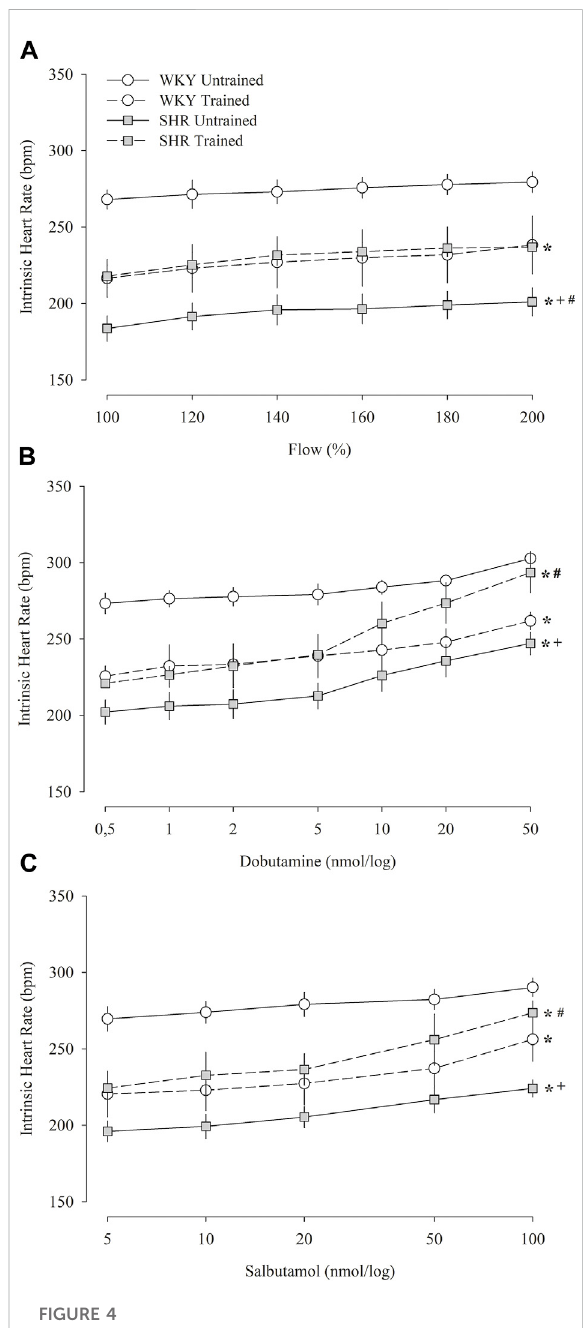
FIGURE 4 Intrinsic heart rate obtained in isolated hearts (Langendorff technique) during thepercent increase in fl ow (A) and after multiple and sequential doses of dobutamine (B) and salbutamol (C) in untrained ( N = 07) and trained ( N = 07) normotensive Wistar Kyoto (WKY)and hypertensivespontaneously rats (SHR).bpm,beats per minute.All valuesarepresentedasthemean± standarderrorof the mean. * p < 0.05 vs. WKY untrained group; + p < 0.05 vs. WKY trained group; # p < 0.05 vs. SHR untrained